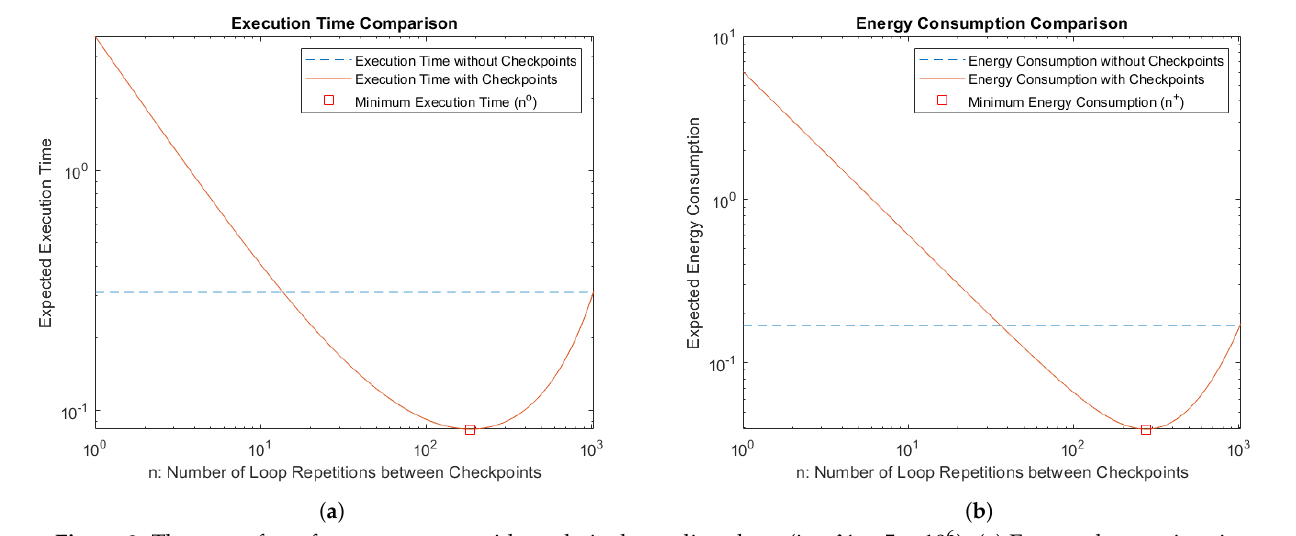
Figure 9. The case of a software program with a relatively medium loop (i.e., Y = 5 × 10 6 ): ( a ) Expected execution time comparison (logarithmic axes) ( b ) Expected energy consumption (logarithmic axes).